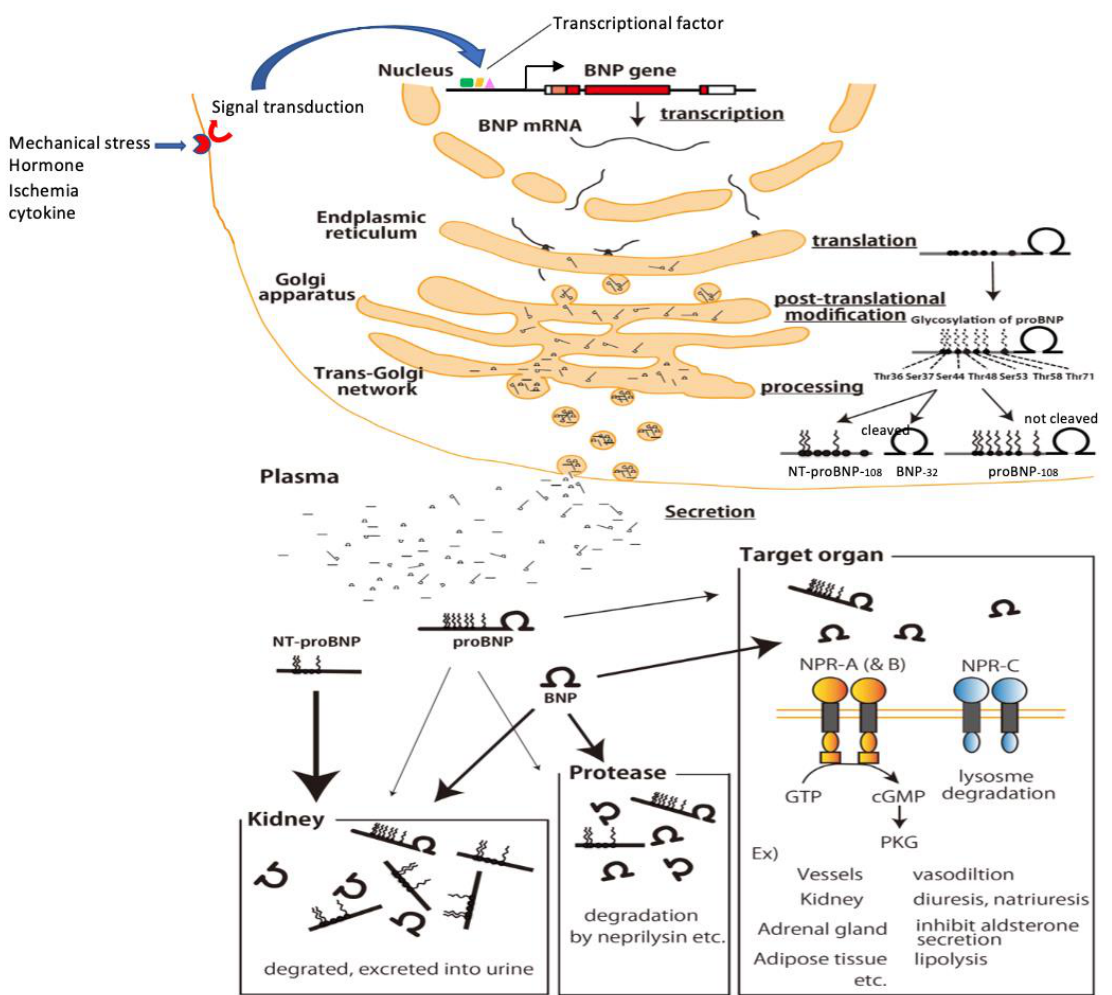
Figure 4. Production, processing, secretion and metabolism of BNP in cardiomyocytes. Mechanical stress, ischemia, hormones, cytokines, etc. stimulate the receptors and enhance BNP gene expression via signal transduction/transcription factors. The enhanced BNP mRNA, which undergoes splicing, crosses the nuclear membrane and is translated in the endoplasmic reticulum to produce preproBNP. The signal peptide is then removed by signalpeptidase, yielding proBNP. As proBNP is transported through the Golgi apparatus, glycosylation occurs at seven sites in the N-terminal region, and within the trans-Golgi network some of the proBNP is cleaved by furin into BNP and NT-proBNP (a portion remains as proBNP). Then, BNP, NT-proBNP, and proBNP are released into the blood.